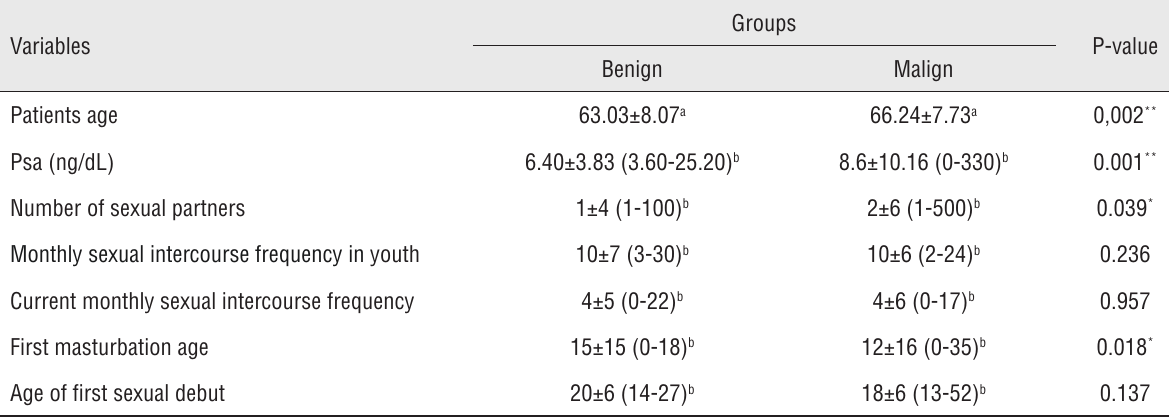
Table 1 - Distribution of data according to malignant and benign